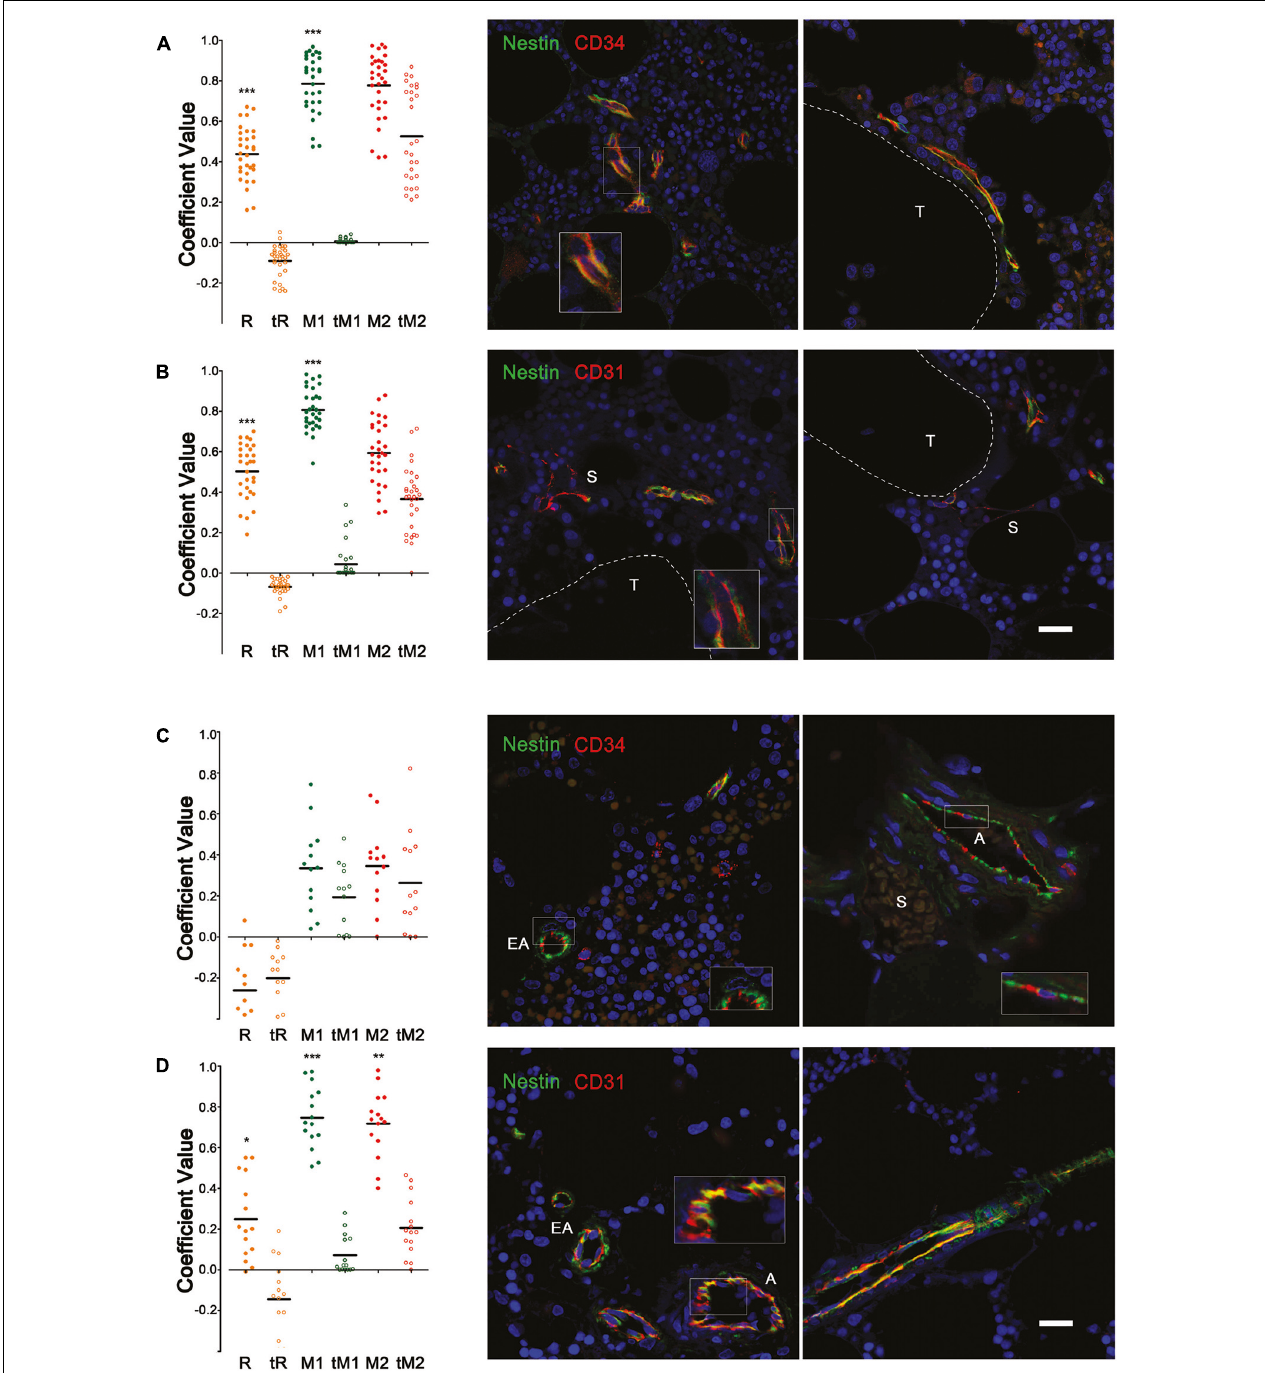
FIGURE 2 | Co-occurrence of NESTIN and endothelial markers in bone marrow vessels. Co-localization analysis of (A) NESTIN and CD34 expression in NCLTs revealed a positive correlation with significant higher Pearson’s coefficient (R) respect to the translated negative control ( t R). Intensity independent Mander’s coefficients showed the almost perfect co-localization of CD34 in the NESTIN channel (M1 respect to t M1), together with no significant co-localization of NESTIN in the CD34 channel (M2 respect to t M2), supporting the “ co-occurrence ” of these two markers that occupy different cell compartment, where NESTIN (green) is cytoskeleton associated protein while CD34 (red) is a cell surface marker. (B) Similar results were obtained analyzing expression of NESTIN and CD31. (C) Co-localization analysis of NESTIN and CD34 expression in A s and EA s did not reveal any correlation with Pearson’s (R) and Mander’s coefficients (M1, M2) similar to the translated negative control ( t R, t M1, and t M2). Indeed, red and green signals resulted spatially segregated in the endothelial vessel walls. Conversely, (D) significant co-occurrence of NESTIN and CD31 were reported, where the NESTIN (green) and CD31 (red) signals overlapped (yellow) in a good portion of the endothelial vessel’s wall. DAPI stain in blue (S = sinusoid, T = bone trabecula, scale bar = 20 µ m, * p < 0.05, ** p < 0.01, *** p < 0.001).